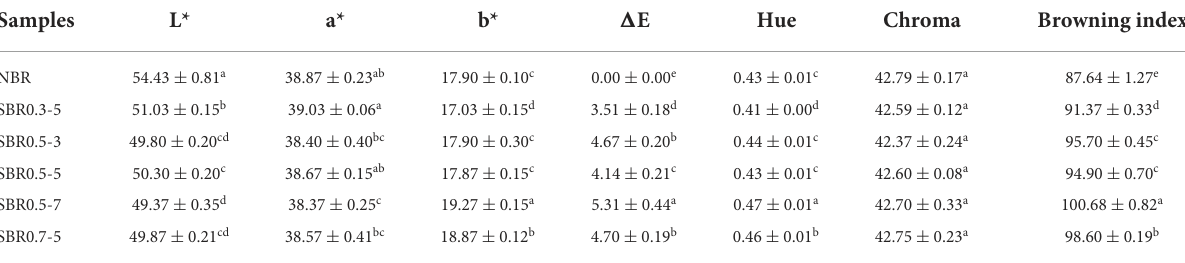
TABLE 1 Effect of steam explosion on the chrominance of brown rice